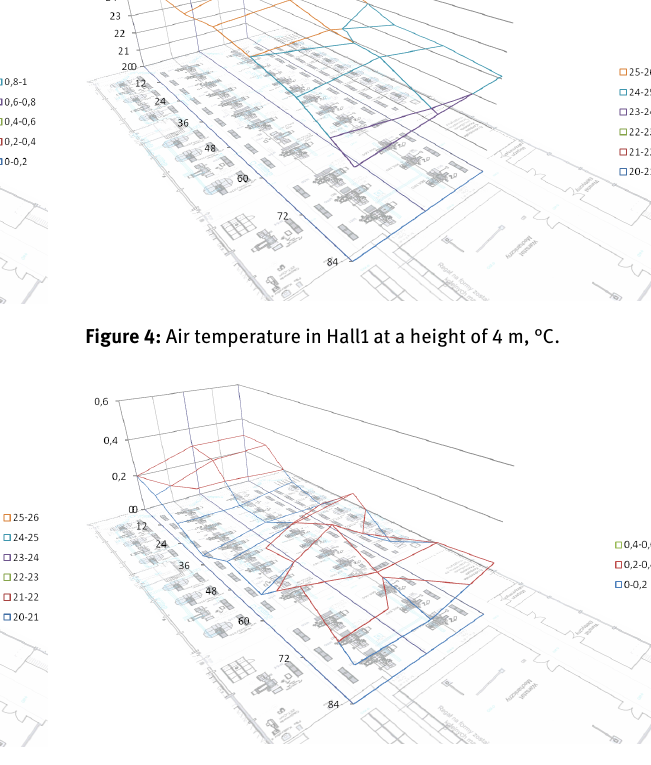
Figure 5: Air velocity in Hall1 at a height of 6 m, m/s.